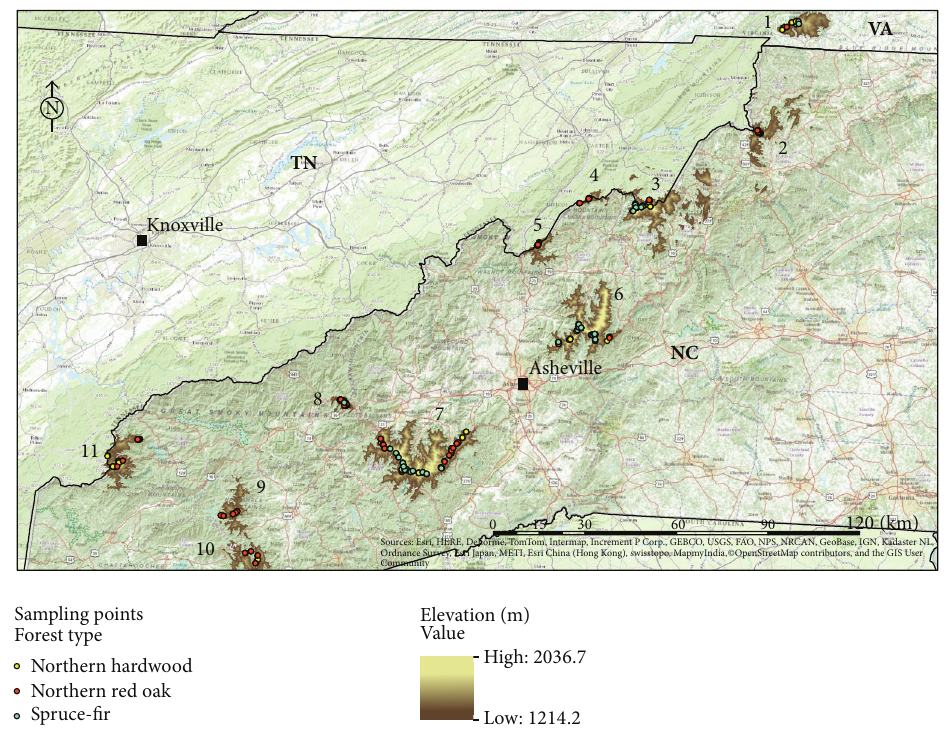
Figure 1: Northern hardwood study areas in Western North Carolina, eastern Tennessee, and southwestern Virginia surveyed in June 2012– January 2013. Mountain ranges or massifs were (1) Grayson Highlands, (2) Elk Knob State Park, (3) Roan Mountain, (4) Unaka Mountain, (5) Big Bald, (6) Black and Craggy Mountains, (7) Great Balsams, (8), Cherokee Reservation, (9) Wayah Bald, (10) the Standing Indian, and (11) Unicoi Mountains. All of these ranges are believed to have populations of Carolina Northern flying squirrel with the exception of the Wayah Bald and the Standing